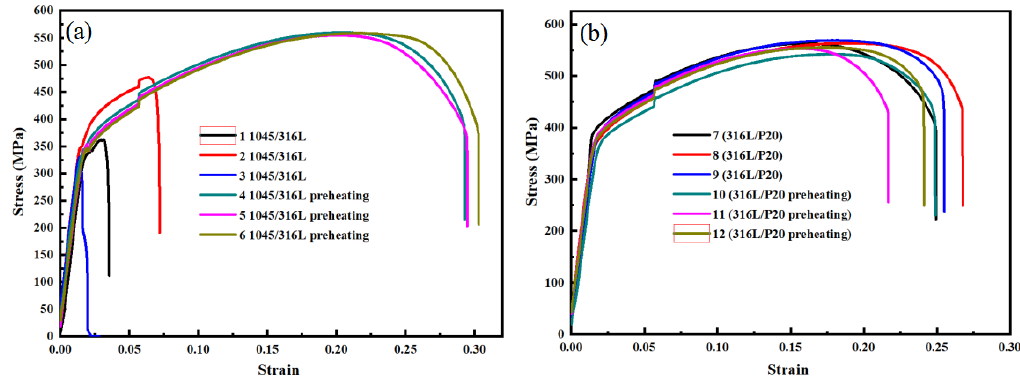
Figure 10. Stress–strain curve of laser metal deposition (LMD) built 316 L with wrought: ( a ) 1045 steel; ( b ) P20 steel.